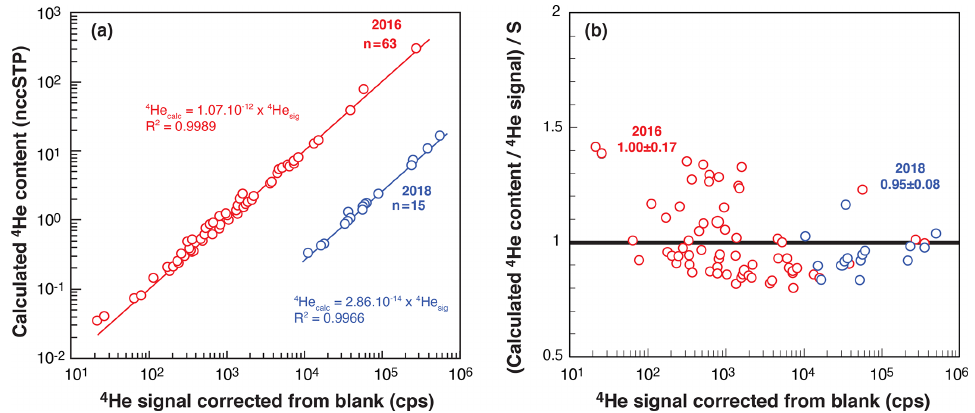
Figure 5. VG5400 ® magnetic sector mass spectrometer sensitivity determined using fragments of Durango apatite. (a) Log–log diagram presenting the calculated 4 He content (nccSTP) versus the measured 4 He signal (cps: counts per second) for two determinations in 2016 and 2018. (b) Ratio of the calculated to measured 4 He normalized to the obtained sensitivity ( S ) versus measured 4 He for both datasets. In 2016, a He sensitivity of 1.1 × 10 − 12 ccSTPHecps − 1 (4.9 × 10 − 17 molHecps − 1 ) was obtained. In 2018, the addition of a cryogenic trap and modifications of source parameters allowed us to obtain a better sensitivity of 2.9 × 10 − 14 ccSTPHecps − 1 (1.3 × 10 − 18 molHecps − 1 ). The variable n is the number of analyzed fragments.